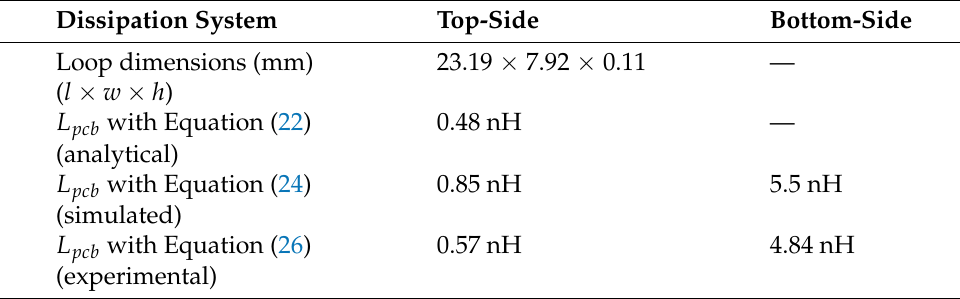
Table 5. Power loop inductance comparison.